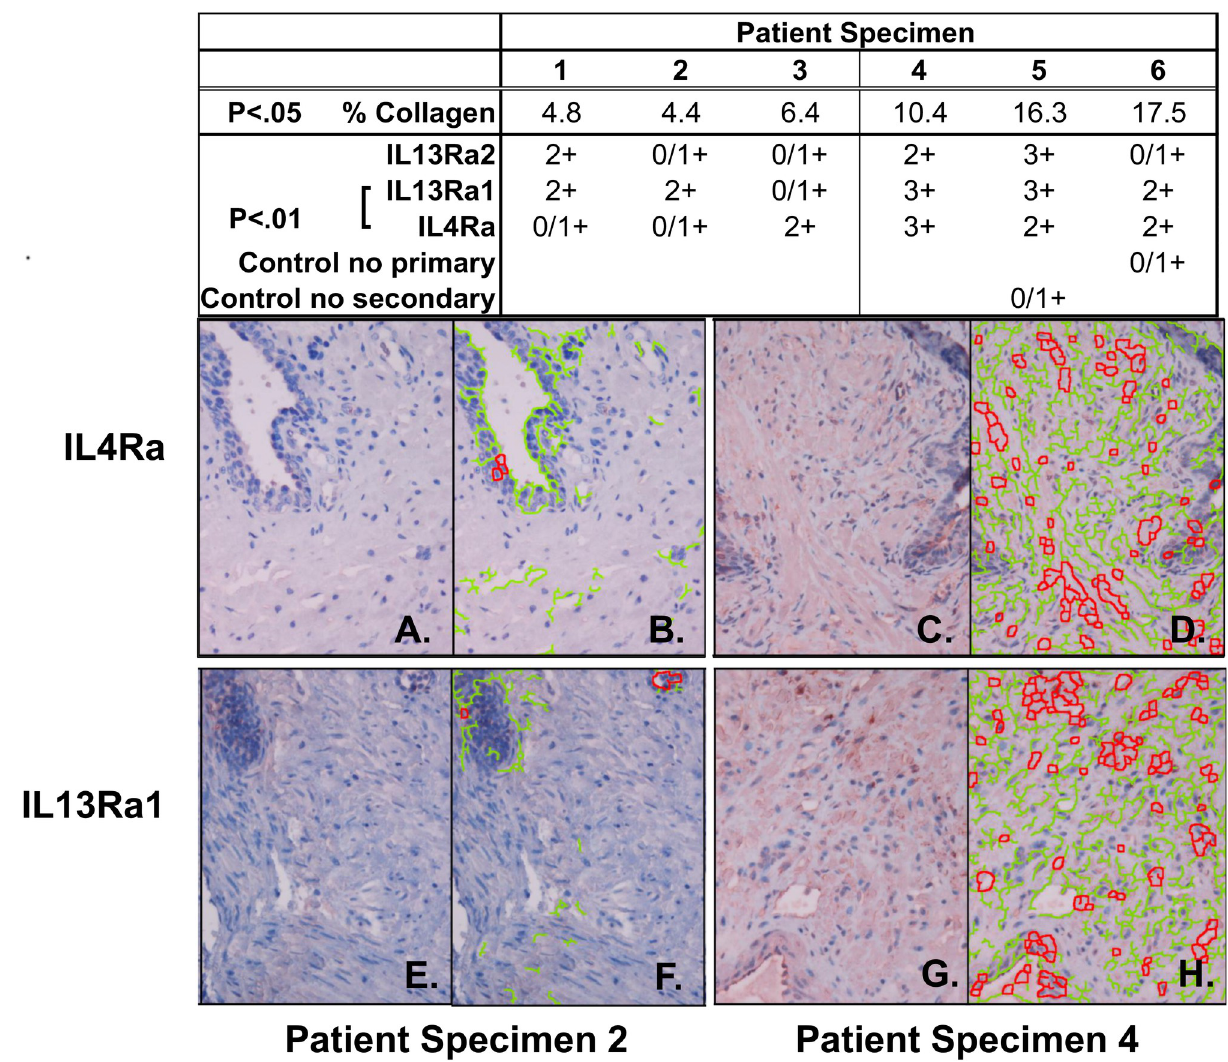
Fig 1. IL-4Ra and IL-13Ra1 are up-regulated in peri-urethral prostate with high collagen content. Tissue sections of peri-urethral prostate tissues from 6 patients were deparaffinized and assessed for collagen content using Masson’s Trichrome Stain [10] or for IL-4R, IL-13Ra1, and IL-13Ra2 protein expression by immunohistochemistry. Tissues from patients 4, 5 and 6 demonstrated significantly higher collagen contents than those from patients 1, 2 and 3 (p < .05) and significantly higher IL13R α 1 (p < .01) and IL4R α (p < .01) protein expression levels. IL-4R α staining is shown for patients 2 ( A, B ) and 4 ( C, D ), and IL-13R α 1 staining also for patients 2 ( E, F ) and 4 ( G, D H. Panels B, D, F and H show the ImmunoRatio analysis of panels A, C, E and G, respectively, where green indicates incomplete/weak (0, 1+) and red indicates complete/strong (2+, 3+) staining (S1